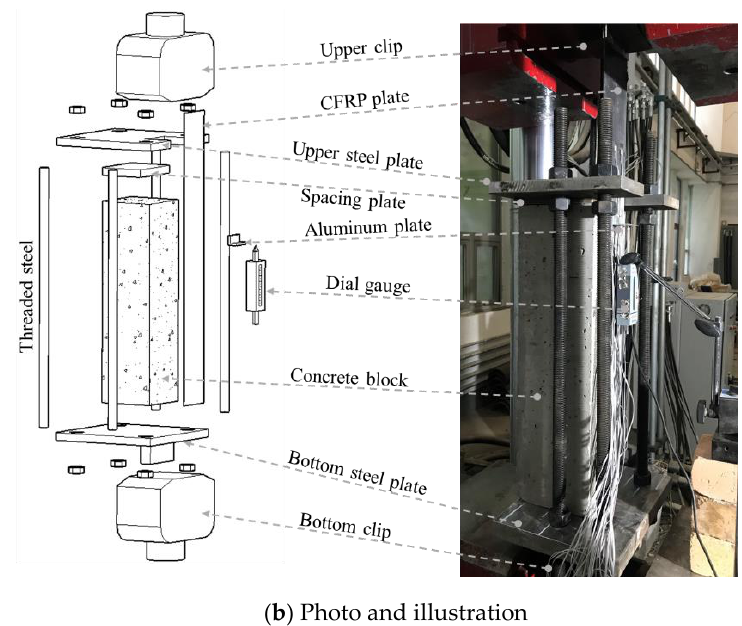
Figure 3. Single shear pull-out test configuration.